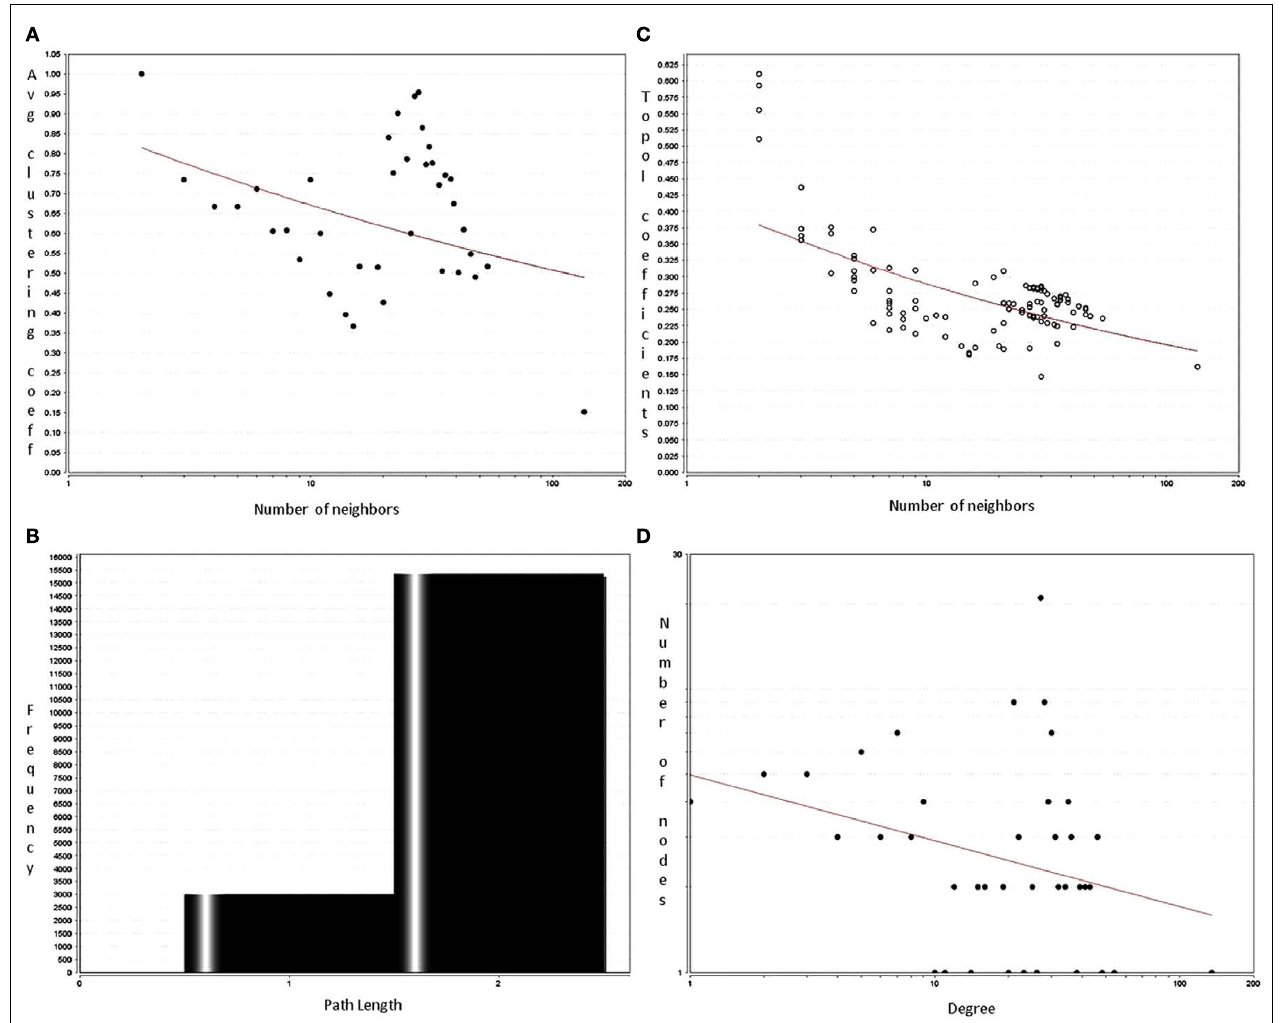
Average clustering coefficient of Sirt-1 network showing constant decrease (D) topological coefficient giving insights on the measure of extent to which a protein in the network shares interaction partners with other